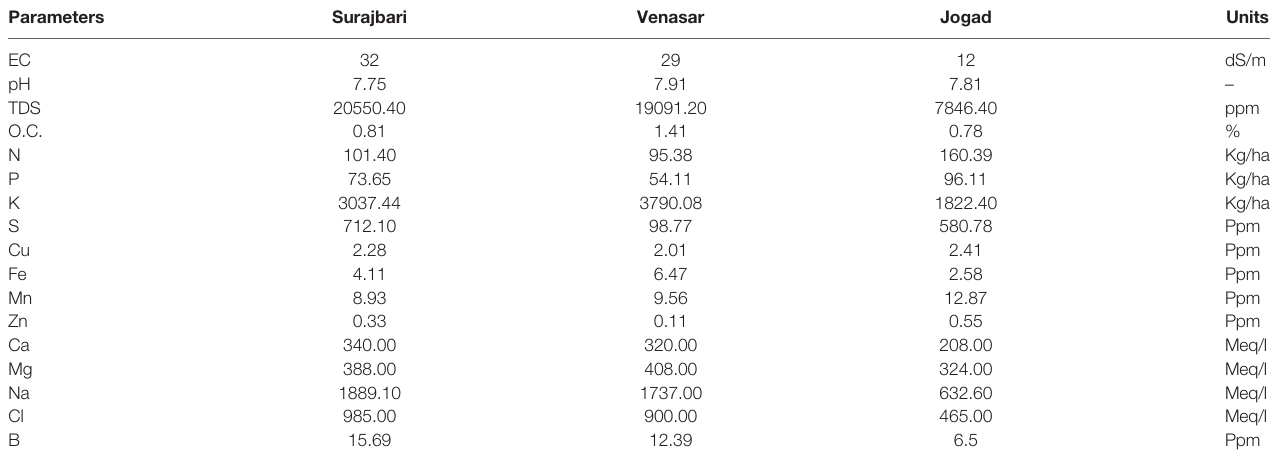
TABLE 1 | Physico-chemical parameters observed in the soil samples collected from Little Rann of Kutch. Parameters